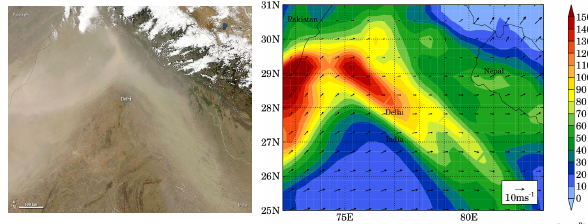
Fig. 4. Natural color image captured by Moderate Resolution Imag- ing Spectroradiometer (MODIS) aboard Aqua on 21 April 2010 at 07:45GMT (left panel) and WRF-Chem simulated spatial distribu- tion of column integrated dust loading at 2.4µm and 10m wind vec- tors over the model domain on 21 April 2010 at 08:00GMT (right panel). The wind vectors are shown every second grid point for clar- ity. Both the images cover same spatial